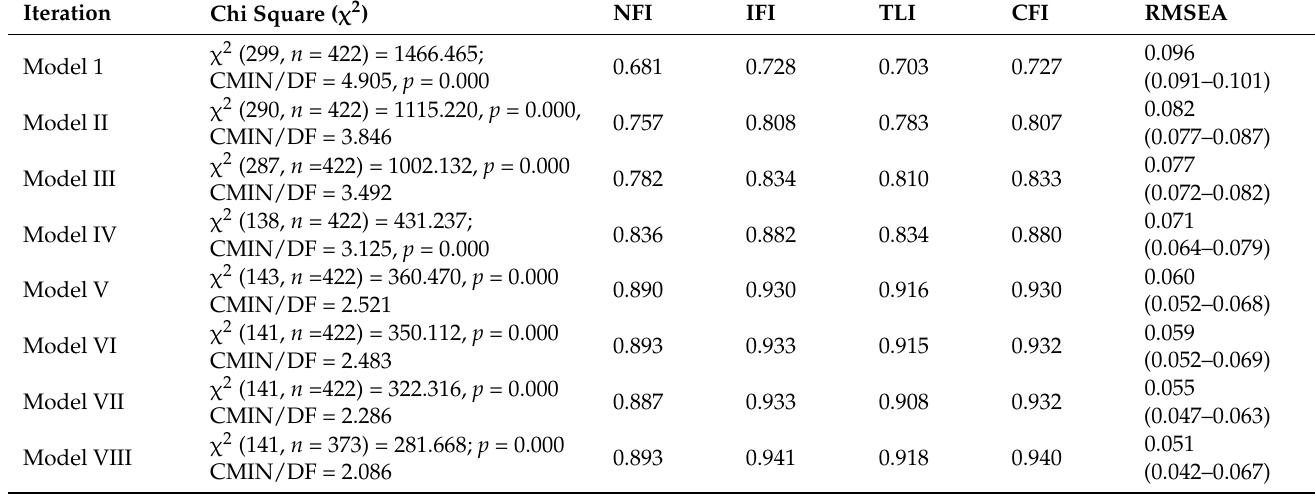
Table A1. Goodness-of-Fit Indices for Fatigue.